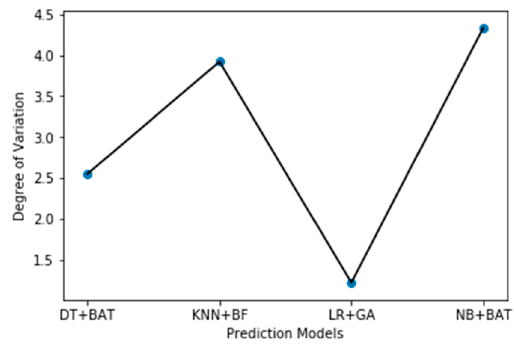
Figure 3. Prediction Models with the Highest Variation.